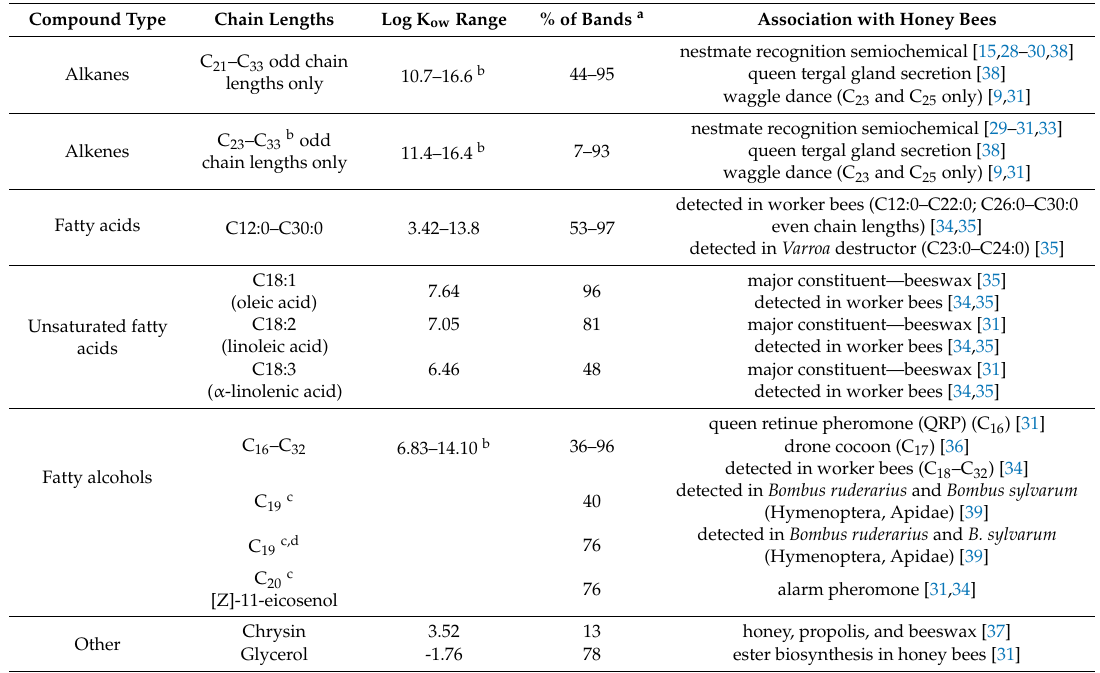
Table 1. The percentage of silicone bands placed in honey bee hives that contain honey bee semiochemicals and honey bee-associated compounds organized by compound